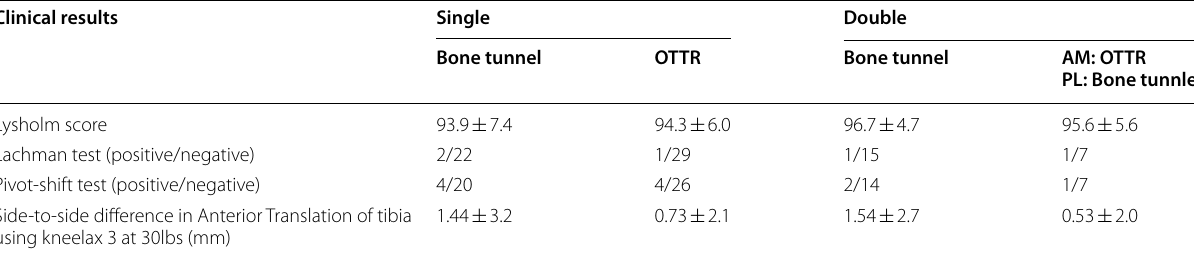
Table 3 A comparison of post-operative results (Lysholm score, Lachman test, Pivot-shift test and side-to-side difference in anterior translation of tibia) among the four